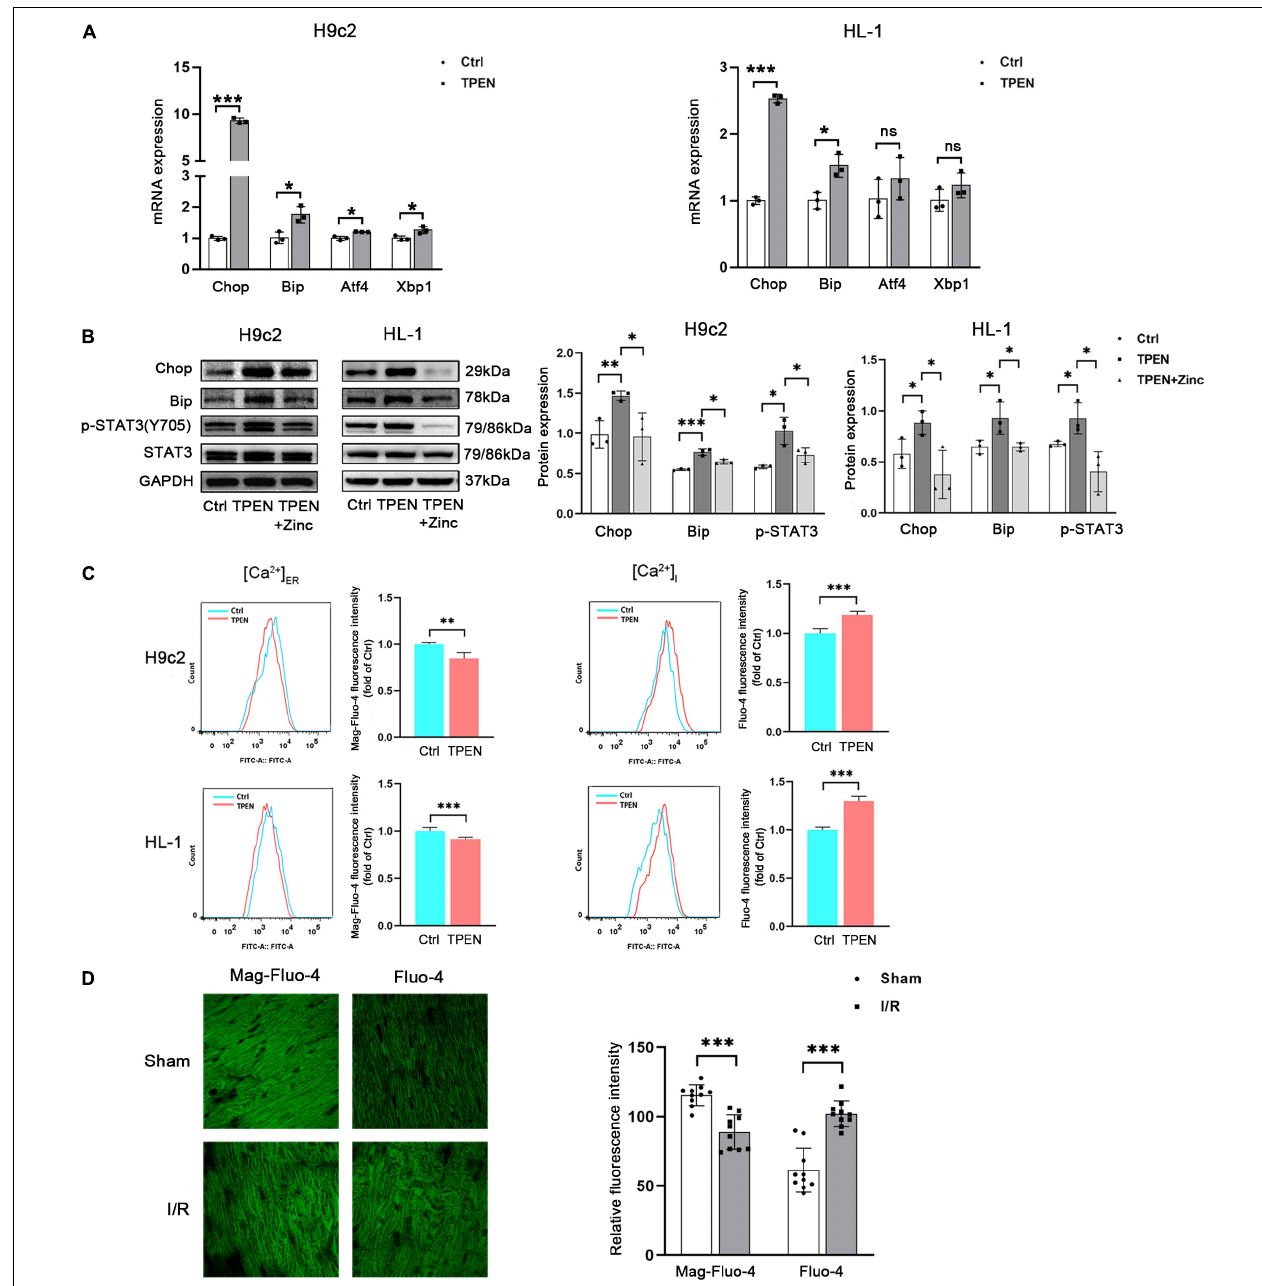
FIGURE 1 | Zinc deficiency can induce ER Stress and Ca 2 + leak. (A) Cells were exposed to TPEN (10 µ M, n = 3) for 4 h. (B) TPEN was applied 1 h before exposure to ZnCl 2 (10 µ M, n = 3) and ionophore pyrithione (4 µ M) for 1 h. (C) ER and free Ca 2 + concentrations in cells were labeled with Mag-fluo4 (5 µ M, n = 3) and Fluo-4 (5 µ M, n = 3), respectively, and detected with confocal microscopy. (D) Mouse hearts were ischemic for 30 min and then reperfused for 30 min. Cardiomyocytes were labeled with Mag-fluo4 (5 µ M) and Fluo-4 (5 µ M), respectively ( n = 10). ∗ p < 0.05, ∗∗ p < 0.01, and ∗∗∗ p < 0.001. ns, no significant difference P >